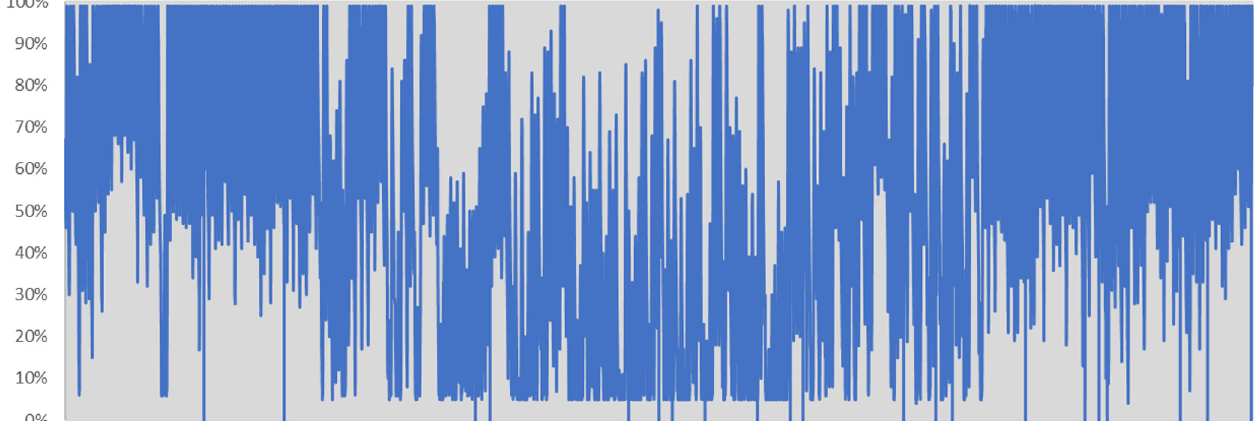
Fig. 3. DESS battery state of charge cycles over year 2016 – observed data.